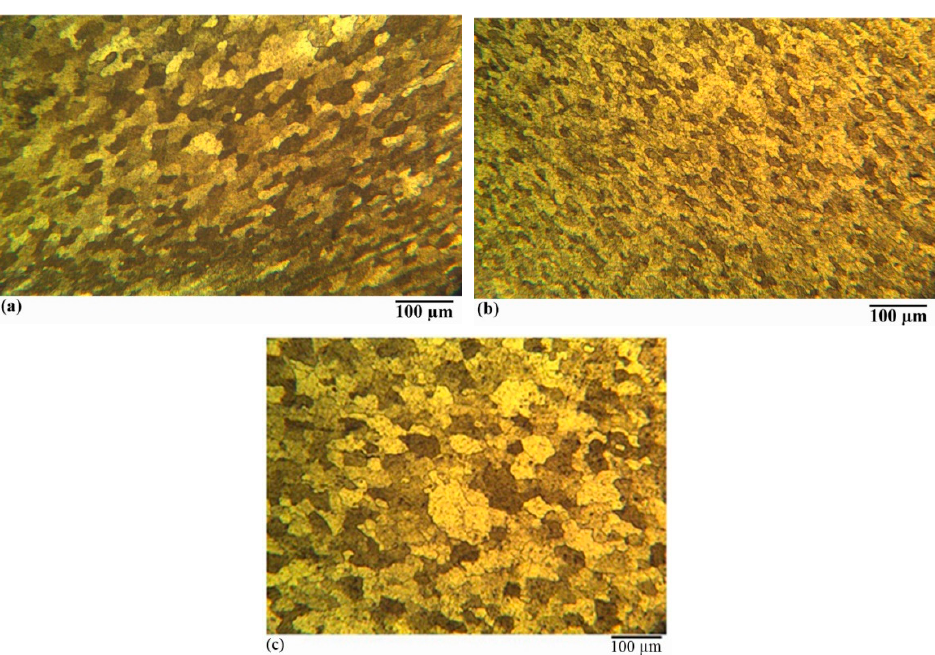
Figure 5. Weld region microstructures of ( a ) FS- and ( b ) FSV-welded specimens.